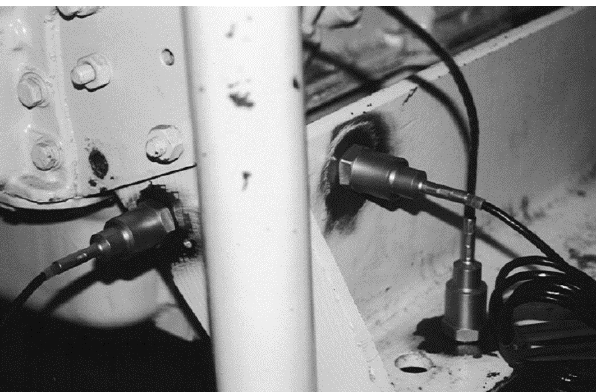
Figure 4. A view of the mounting point of the accelerometers on the foundation frame used for measuring vibrations in three directions.